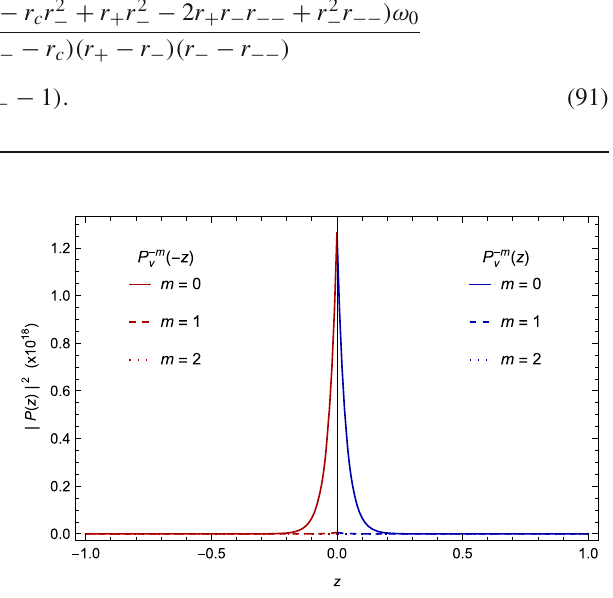
Fig. 7 (dS) Case 2: a > 0. The first three squared QBS angular wave eigenfunctions as a function of the new polar coordinate z ; a = 0 . 20, (cid:2) = 0 . 1, n = 0, M = 1 /